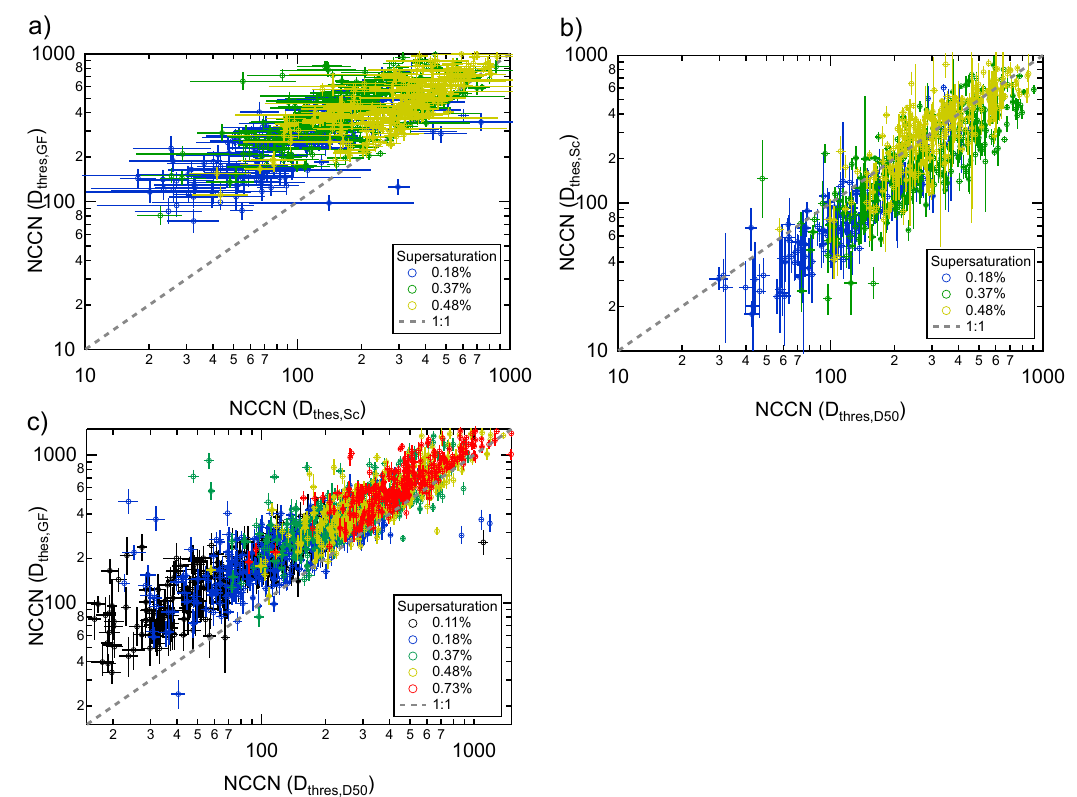
Fig. 10. N CCN vs. N CCN for: (a) HTDMA vs. CCNc S-step analysis; (b) CCNc S-step analysis vs. CCNc D-step analysis; (c) HTDMA vs. CCNc D-step analysis.